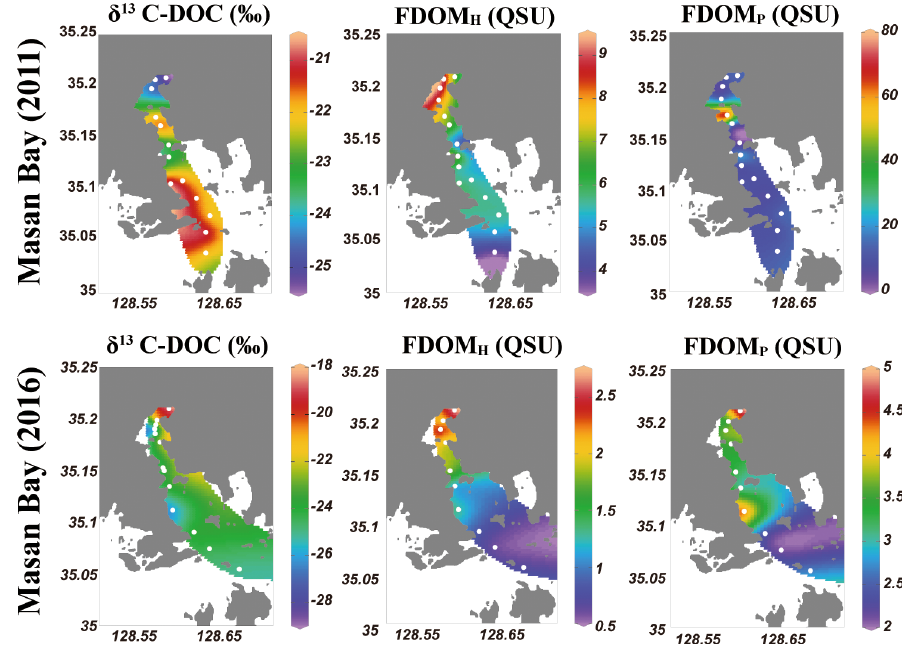
Figure 3. Surface distributions of δ 13 C-DOC, FDOM H , and FDOM P in Masan Bay, Republic of Korea, in 2011 and